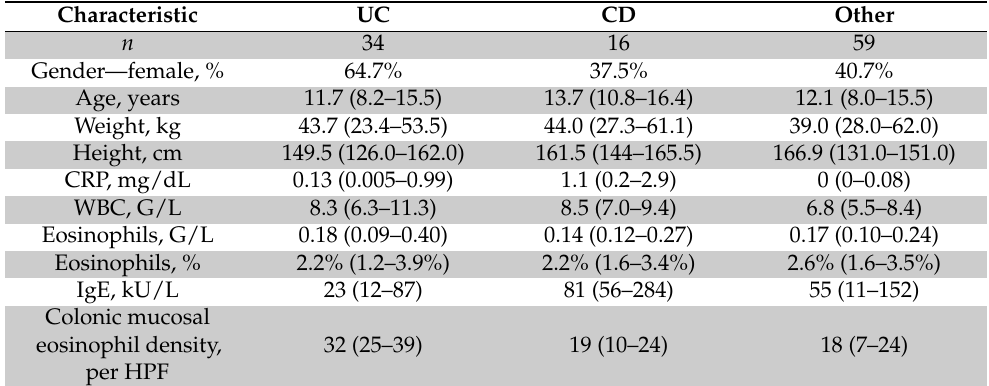
Table 1. Main characteristics of patients depending on final diagnosis